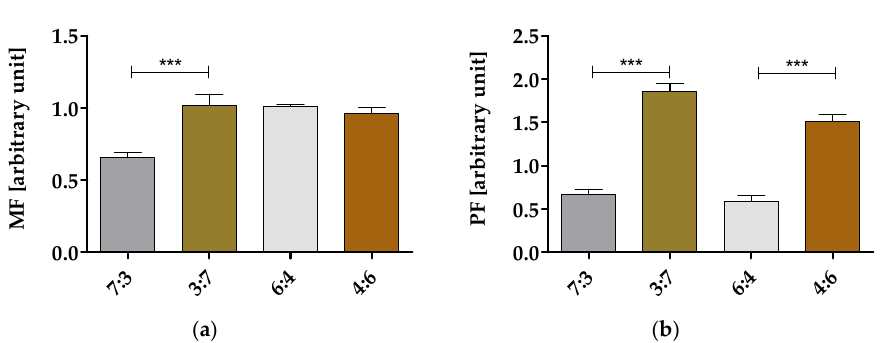
Figure 1. Metabolic and proliferative activity of hASCs cultivated onto investigated (TPU+PLA) films. The metabolic and proliferative factor was determined in relation to the cultures propagated on polystyrene. The analysis was performed after 120 h of hASCs culture in obtained matrices. An asterisk marks a statistically significant difference (*** p < 0.001).